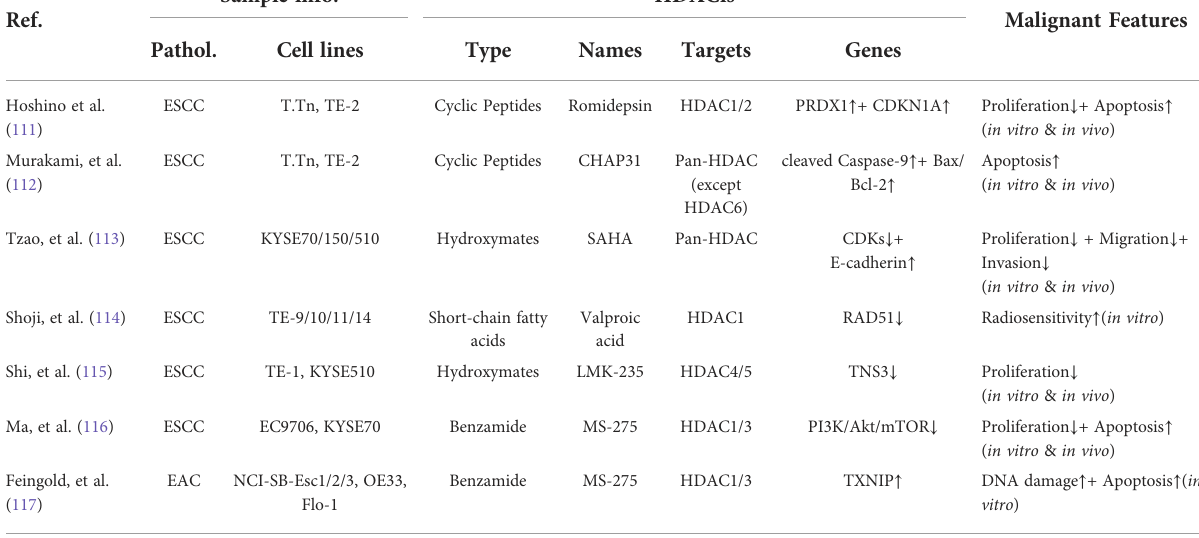
TABLE 4 The molecular mechanism of histone deacetylase inhibitors against esophageal carcinoma.